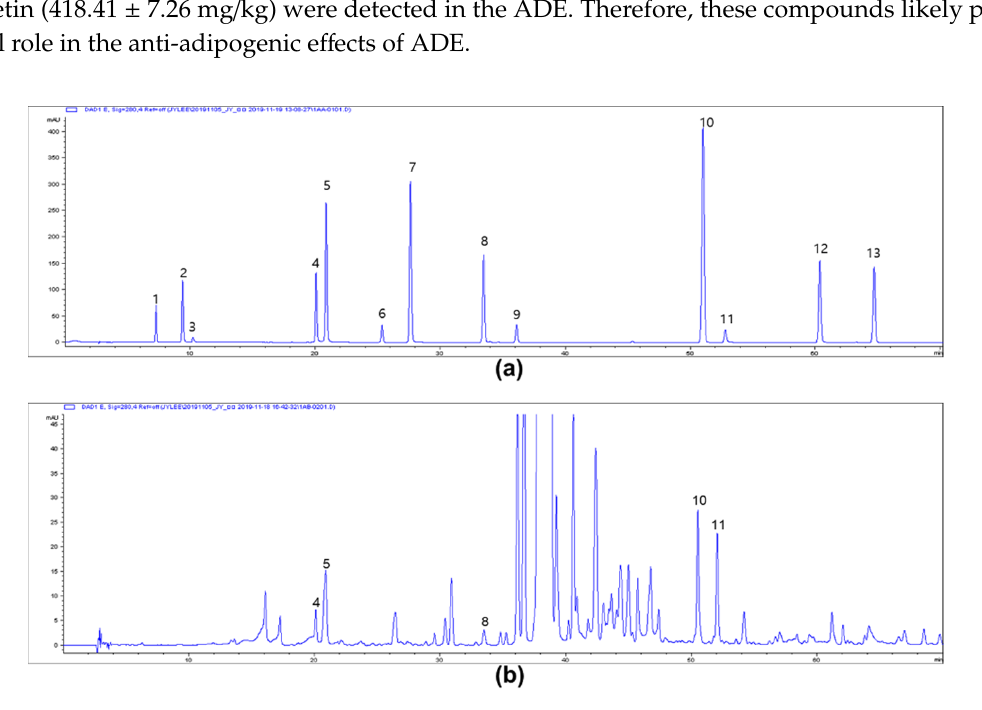
Table 3. HPLC analysis of phenolics extracted from A. dioicus .